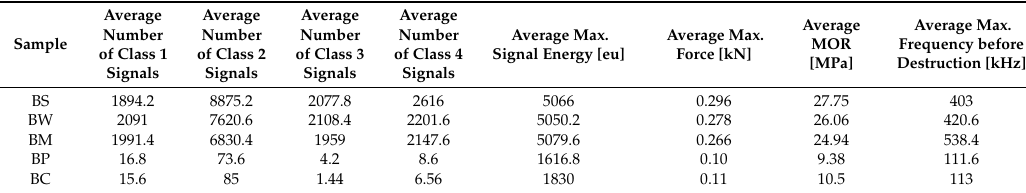
Table 9. Summary of research